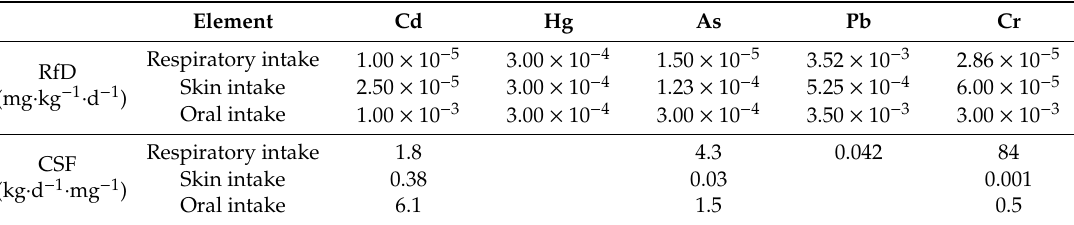
Table 1. Non-carcinogenic response doses of six non-carcinogenic potentially toxic elements (PTEs) and the carcinogenic intensity coe ffi cients of two carcinogenic